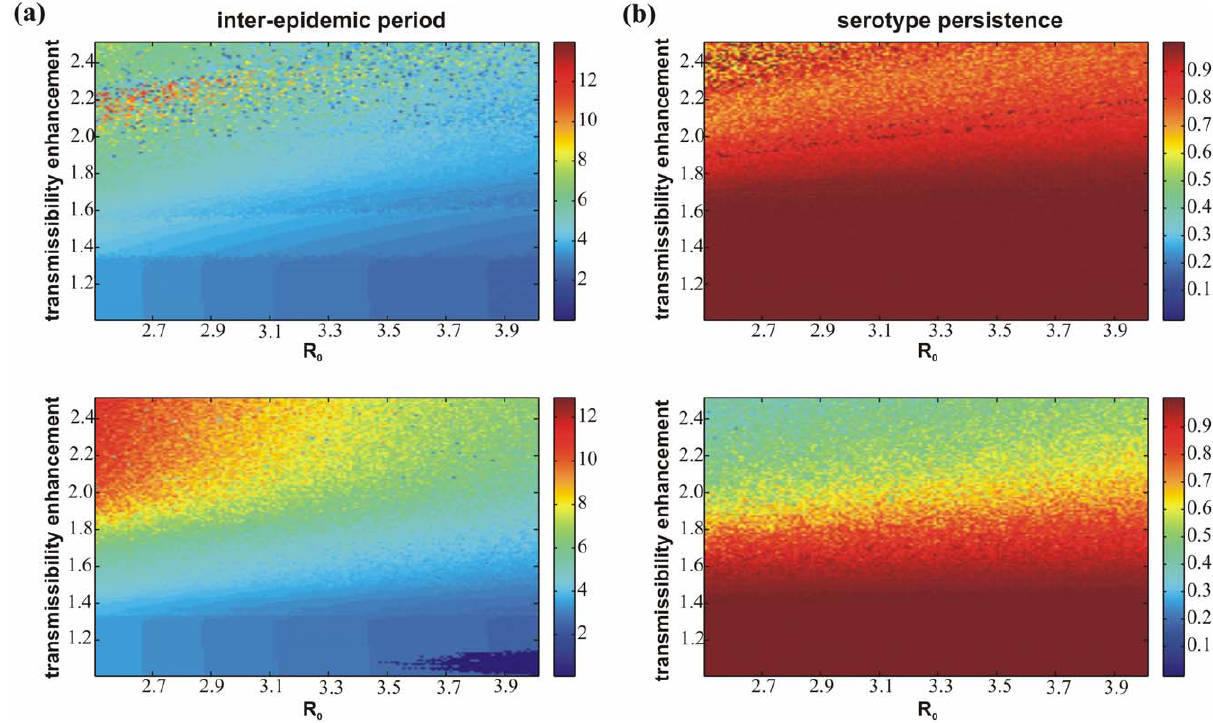
Figure 4. Comparison of inter-epidemic period and serotype persistence between model (i) ( top ) and model (ii) ( bottom ). (a) As enhancement increases so too does the epidemic period observed in each model. There is also a trend towards longer periods at lower R 0 . However, these trends both appear to be stronger in model (ii). (b) The risk of stochastic extinction within the model is shown as the proportion of time in each model that the prevalence of a particular serotype exists above a specific threshold. In both models there is a low risk of extinction but the risk increases with enhancement; again, this trend is stronger in model (ii).